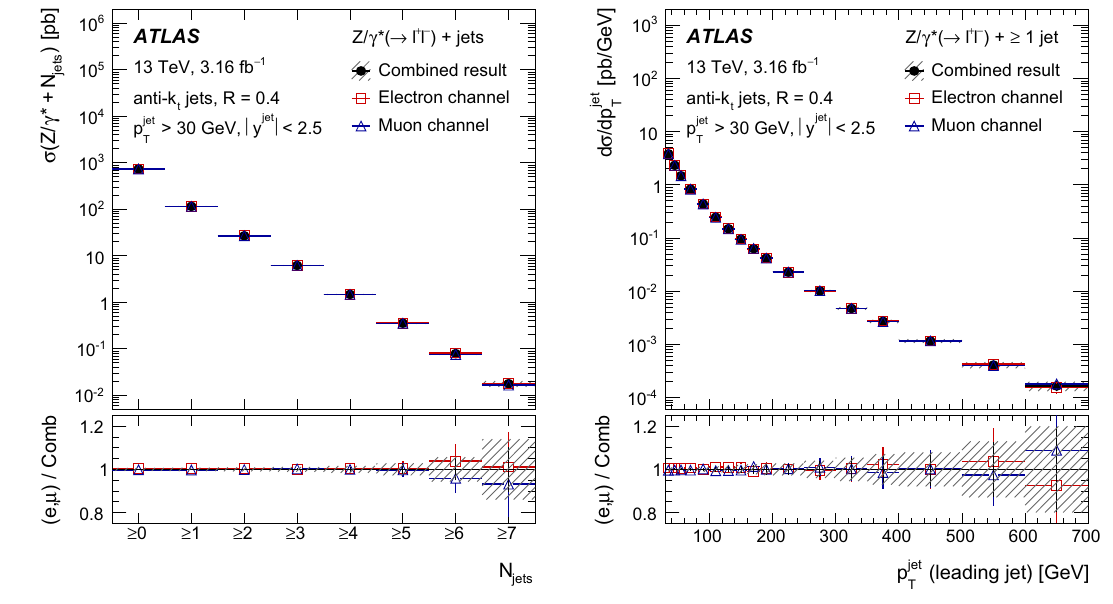
combined results are also shown in the bottom panels . The error bars indicate the statistical uncertainty, and the hatched bands the statistical and the flavour-uncorrelated systematic uncertainties of the combined result, added in quadrature